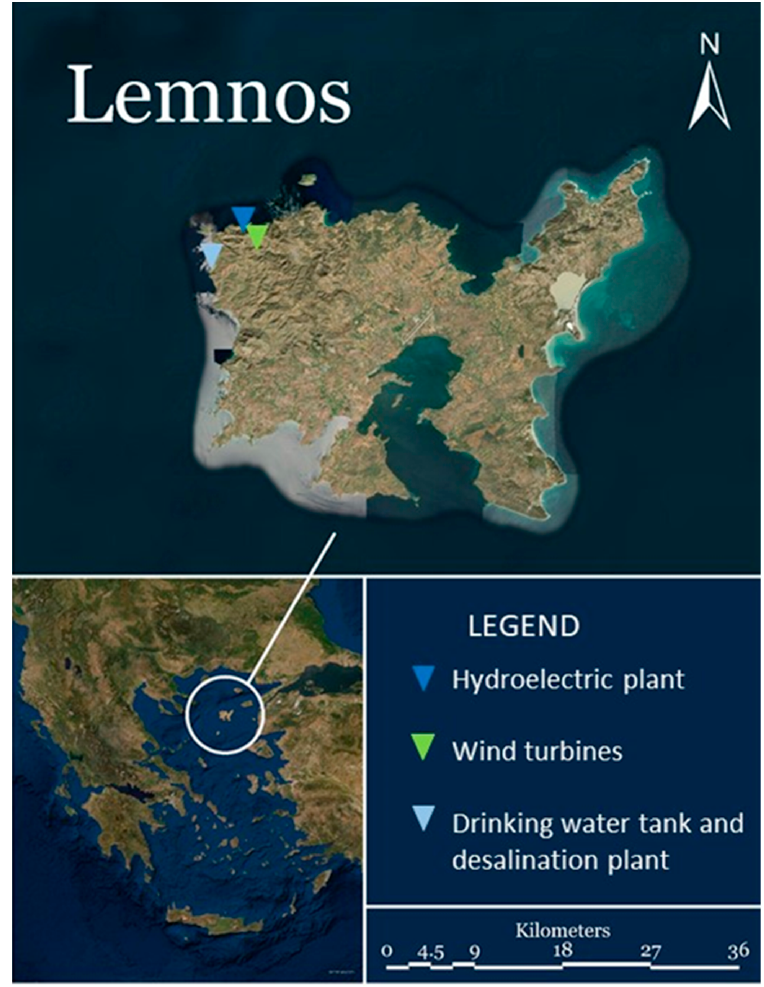
Figure 6. Positioning of the units of HRES (source: ArcGIS Pro).